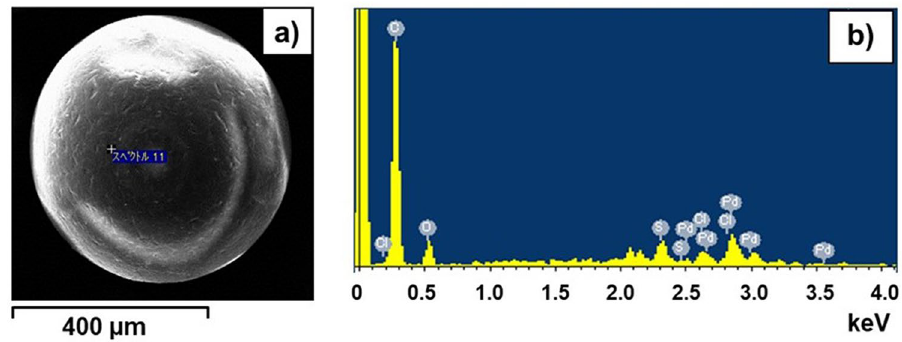
Figure 3. ( a ) SEM image and ( b ) EDX spectrum after Pd(II) sorption by 1